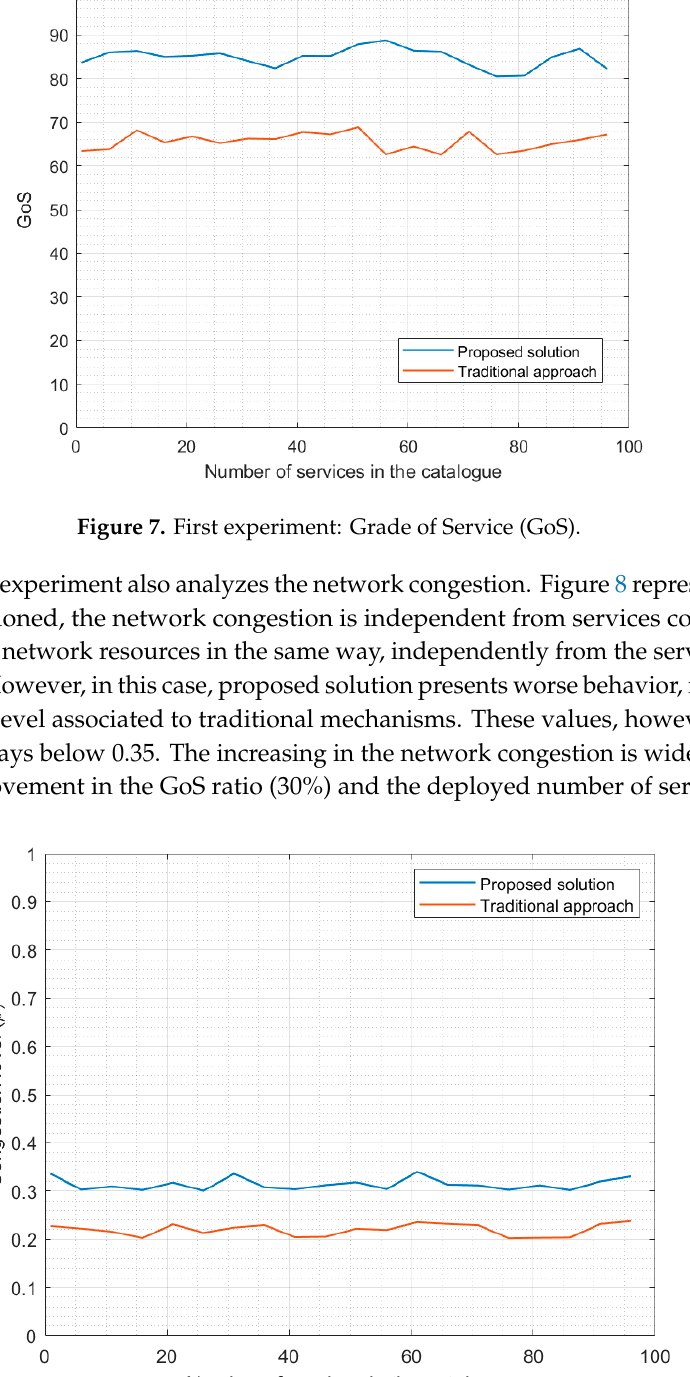
Figure 9. Second experiment: scalability analysis.